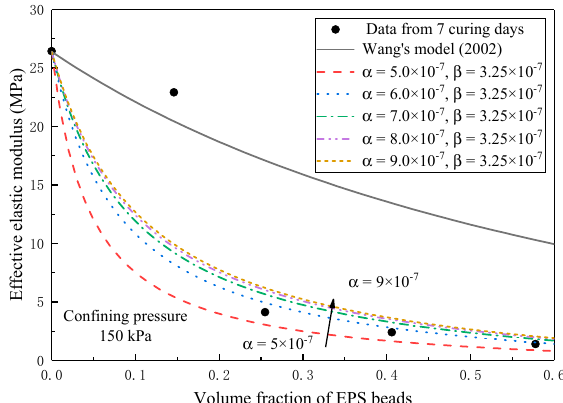
Figure 7. E ff ect of imperfect interface parameter α on e ff ective elastic modulus under confining pressure Figure 7. Effect of imperfect interface parameter α on effective elastic modulus under confining of 150 kPa. pressure of 150 kPa.